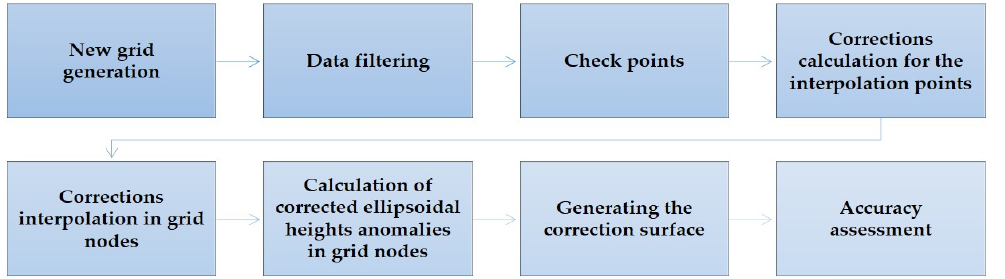
Figure 13. Workflow diagram for generating the surface for correcting the EGG2008 gravimetric quasigeoid.